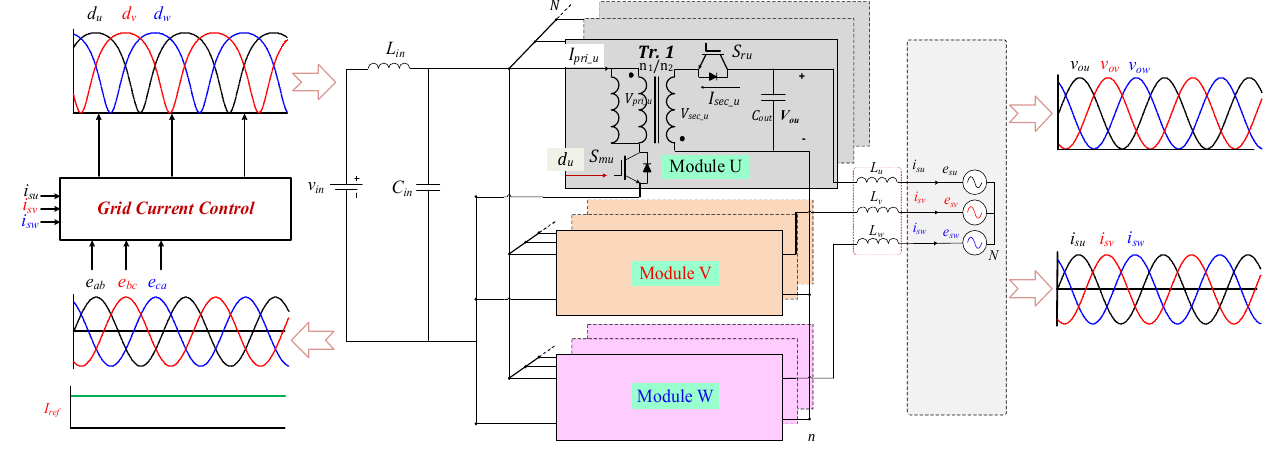
Figure 1. Circuit configuration of the single-stage three-phase MFBDI.